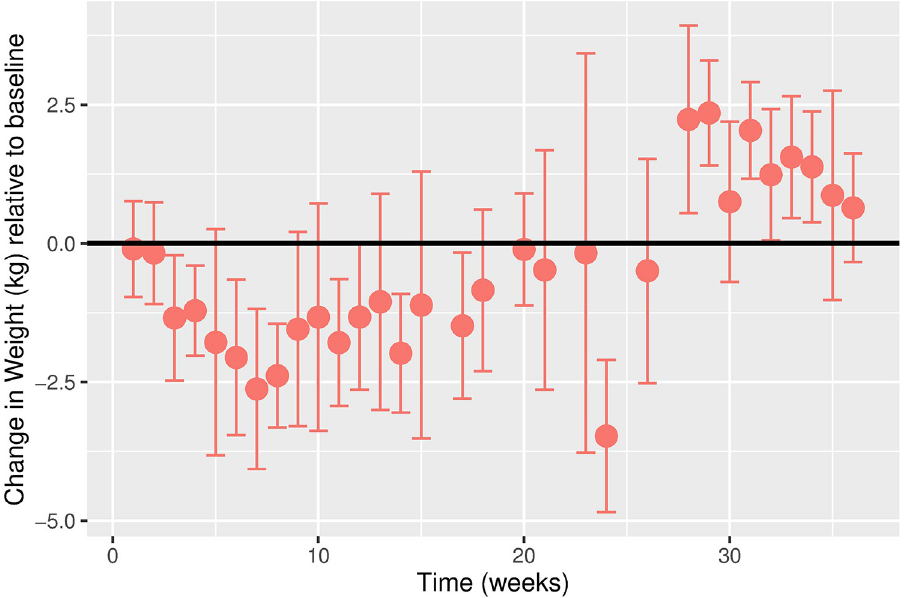
Fig 6. Estimated change in weight (kg) relative to baseline over time in weeks for pre-diabetic individuals (HbA1c between 5.7% and 6.5%). Error bars represent the 95% confidence intervals. Change in Weight (kg) relative to baseline. Time (weeks). Error bars represent the 95% confidence intervals.